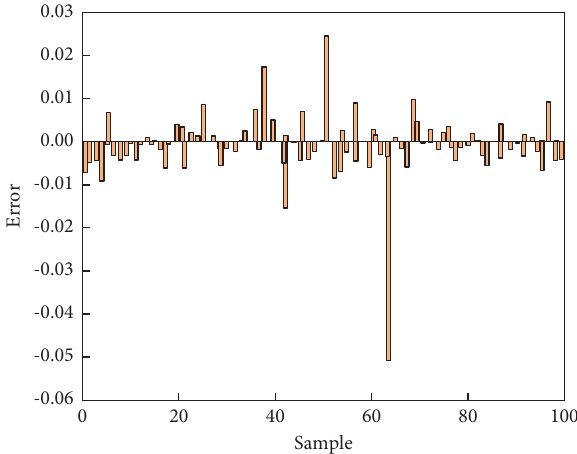
Figure 6: Network training